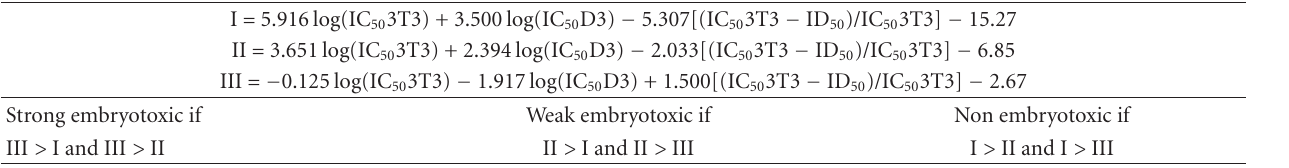
Table 2: The linear discriminant functions and classification criteria considered in EST for assessing the embryotoxicity potential of chemicals. Data taken from [11]. IC 50 D3 was defined as the concentration that reduces the viability of D3 cells by 50% after 10 days of exposure. IC 50 3T3 was defined as the concentration that reduces the viability of 3T3 cells by 50% after 10 days of exposure. ID 50 was defined as the concentration that inhibits the spontaneous di ff erentiation of D3 embryoid bodies to contractile cardiomyocytes by 50%. IC 50 D3, IC 50 3T3, and ID 50 must necessarily be expressed in μ